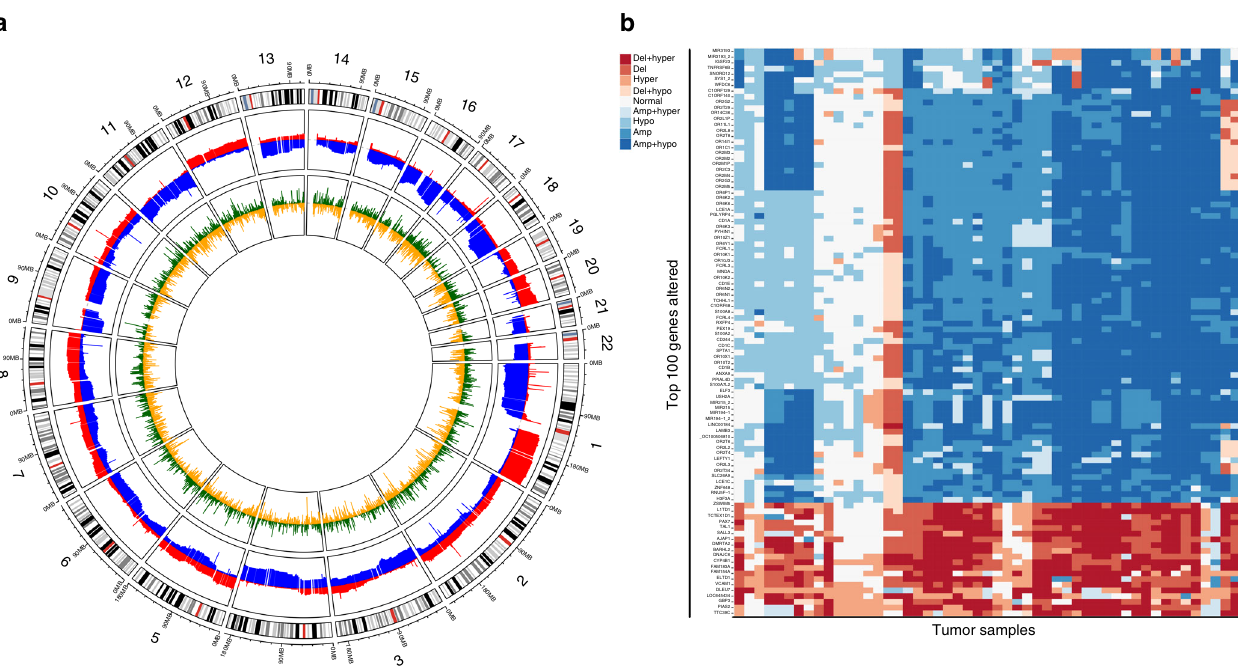
Fig. 4 Frequent molecular alterations can be identi fi ed in ACC. a Circos plot displaying all autosomes (outer circle, grey, centrosomes red) with ampli fi cations (middle circle, red), deletions (middle circle, blue), hypermethylation (inner circle, green), hypomethylation (inner circle, yellow). b Heatmap of top 100 genes encompassing copy number aberrations and differential promoter methylation; red: leading to loss of gene function, blue: leading to gain of gene function. The darker the color the more aberrations were